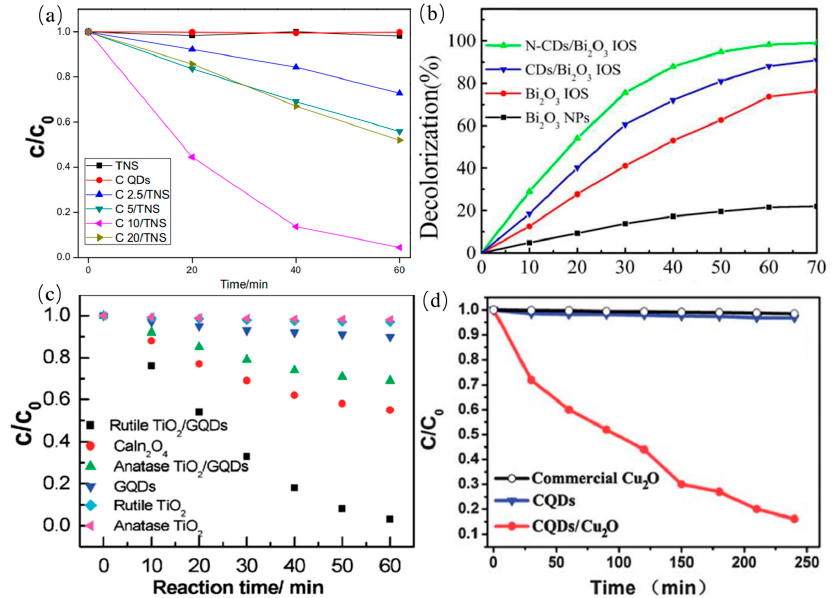
Figure 23. Degradation of RhB by ( a ) CQDs/TNS composites photocatalyst [168]. Copyright 2014, Elsevier. ( b ) N-CDs/Bi 2 O 3 composite photocatalyst; degradation of MB [169]. Copyright 2015, Royal Society of Chemistry. ( c ) CDs/rutile TiO 2 composite photocatalyst [55]. Copyright 2012, American Chemical Society. ( d ) GQDs/Cu 2 O composite photocatalyst [170]. Copyright 2012, Royal Society of Chemistry.